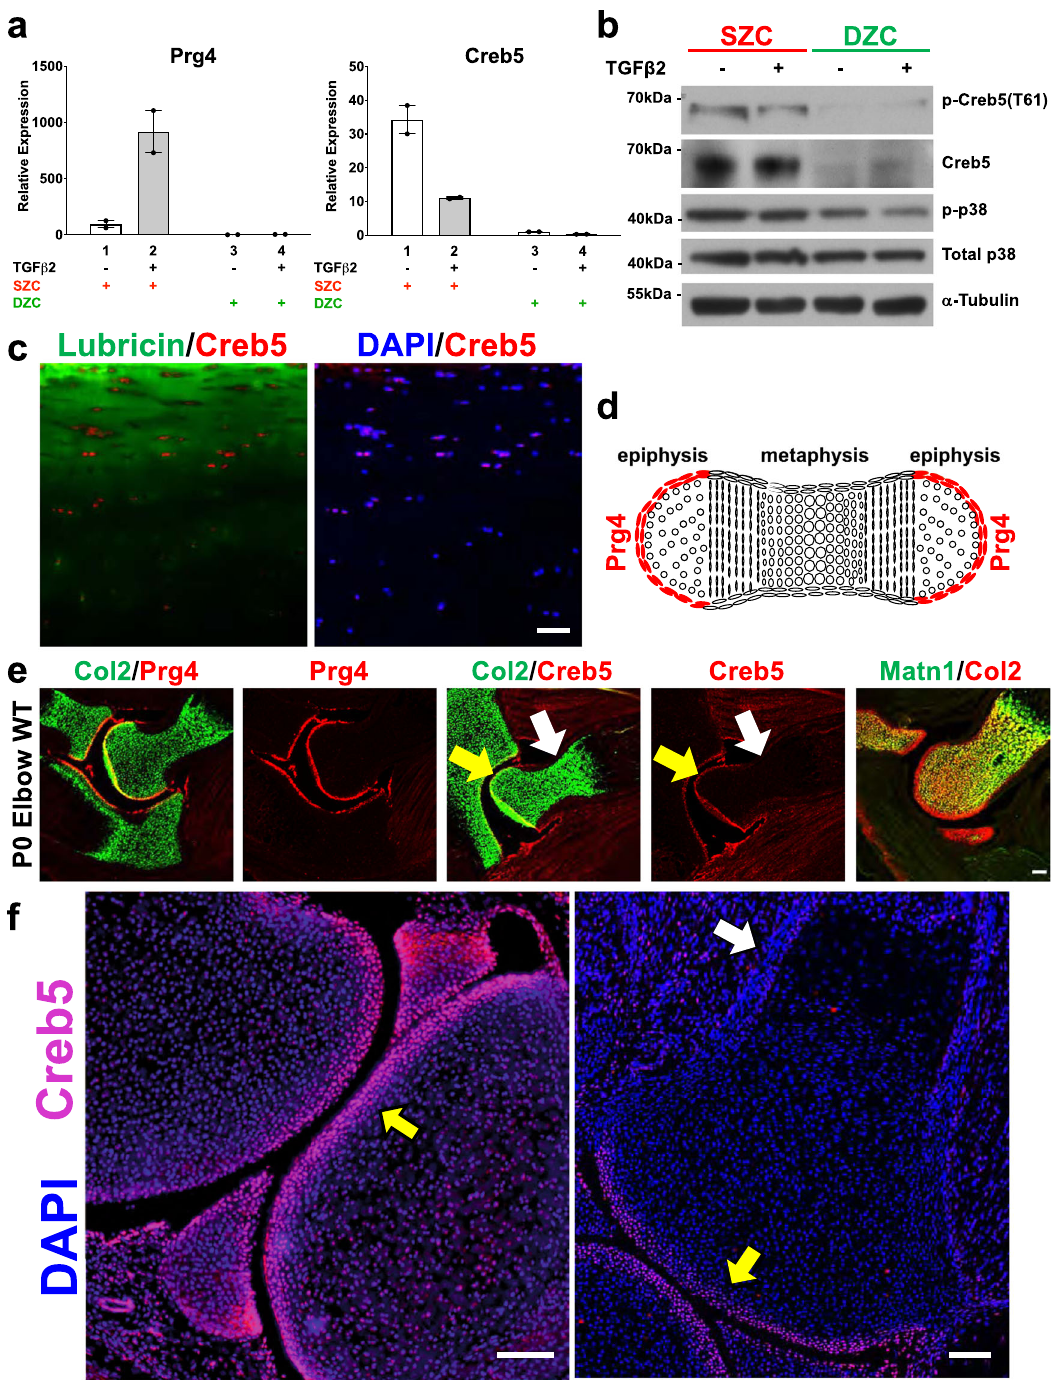
Fig. 2 The transcription factor Creb5 is differentially expressed in super fi cial versus deep zone articular chondrocytes and is speci fi cally expressed in Prg4 + cells in synovial joints. a RT-qPCR analysis of Prg4 and Creb5 expression in either SZCs or DZCs cultured in either the absence (white) or presence (gray) of TGF- β 2 (20 ng/ml) for 3 days. Gene expression was assayed by RT-qPCR and normalized to Gapdh . Error bar indicates standard error of the mean ( n = 2 technical repeats). Similar results have been obtained in three independent biological repeats. b Western analysis of proteins in SZCs and DZCs. Similar results have been obtained in two independent biological repeats. c Immuno fl uorescent staining for CREB5, lubricin, and DAPI (to visualize nuclei) in adult human femoral head articular cartilage. Scale bar equals 50 microns. d Schematic of Prg4 expression in a developing long bone cartilage element. e Expression of Collagen 2a1 (Col2), Prg4, Creb5 , and Matrilin1 (Matn1) in the elbows of P0 mice, as detected by fl uorescent in situ hybridization. f Immuno fl uorescent staining for Creb5 protein and DAPI (to visualize nuclei) in the knee joint of a P0 mouse. In ( e , f ), the Creb5-expressing articular perichondrium is designated by a yellow arrow, the metaphyseal perichondrium is designated by a white arrow; and the scale bars equal 100 microns.